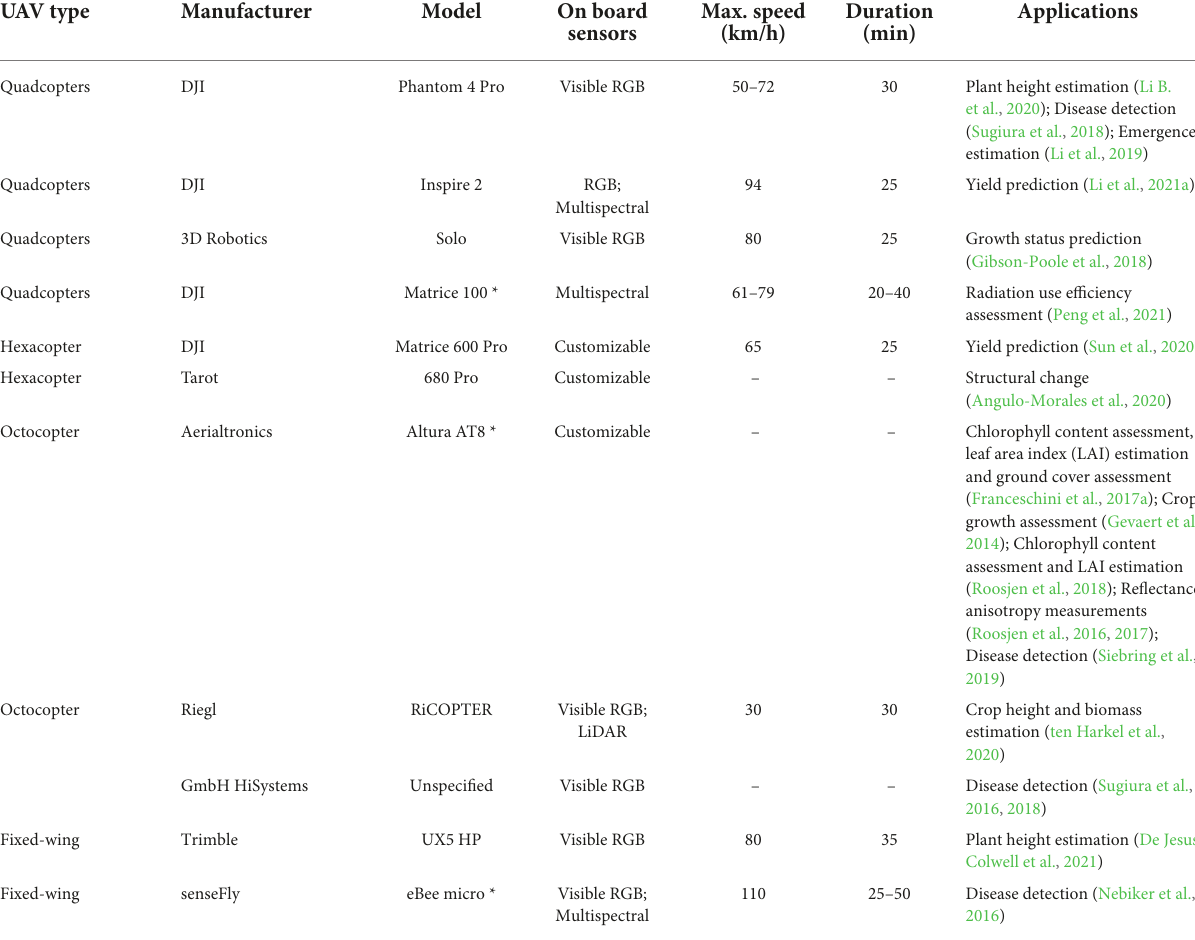
TABLE 3 UAV-based remote sensing platforms and their applications in potato traits